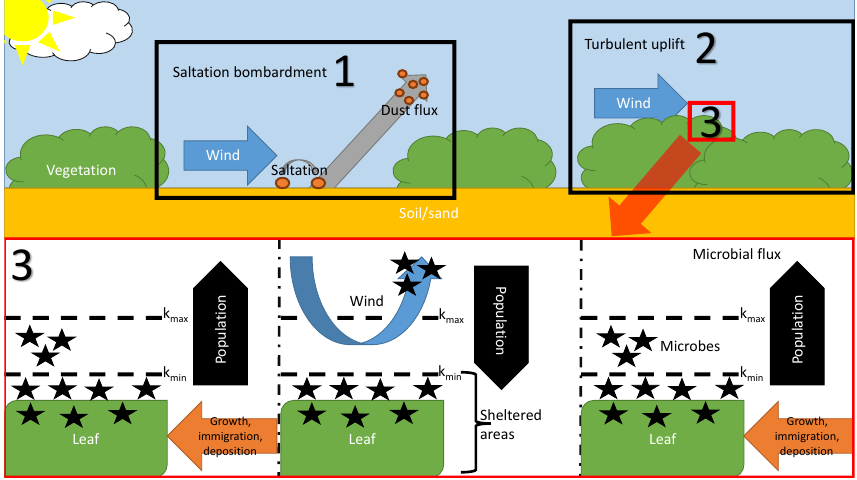
Figure 2. Schematics of the differences between Aeolian dust flux and microbial flux on which the PLAnET model is founded. Box 1 (top left) shows the typical dust saltation mechanism. The action of wind (blue arrow) on soil makes dust particles (orange dots) “jump” for short distances, ejecting smaller dust particles in the atmosphere. Turbulent uplift is shown in box 2 (upper right) where wind acts on the phyllosphere. What happens in the small red box 3 is indicated in more detail in the lower part of the figure (as indicated by the red arrow). The phyllosphere harbors a given number of microbial particles (black stars) up to a maximum (carrying capacity, k max in the figure). Wind can remove a certain fraction of “available” microorganisms up to the limit of a sheltered fraction of the population ( k min in the figure). While the action of wind decreases the number of particles on the leaf, the population keeps experiencing phenomena such as growth, immigration from other leaves and deposition of airborne particles, all contributing to an increase in population. The balance between population dynamics and uplift is what contributes to the net flux simulated by the PLAnET